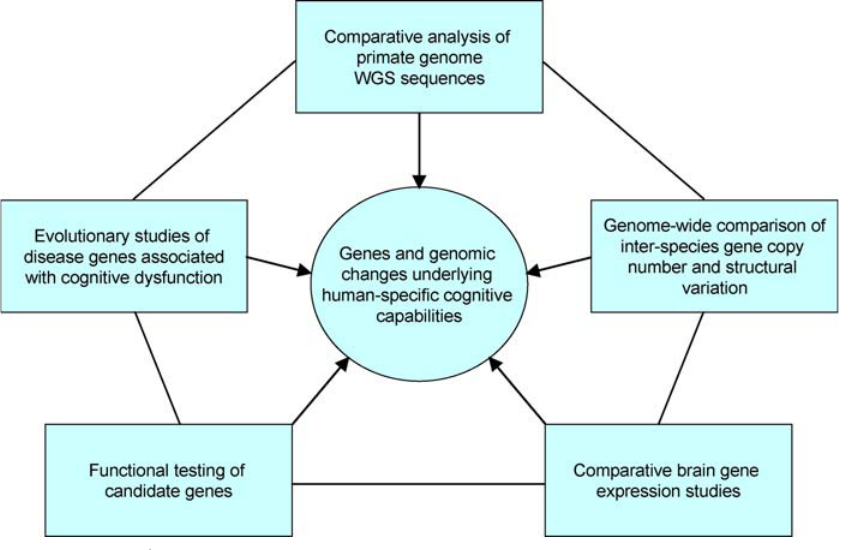
Figure 4. Strategies for Identification of Genes and Genomic Changes Underlying the Evolution of Human-Specific Cognitive Capabilities Listed are various strategies that, either independently or in combination, have the potential to identify gene or genomic changes and pathways relevant to the evolution of human-specific cognitive